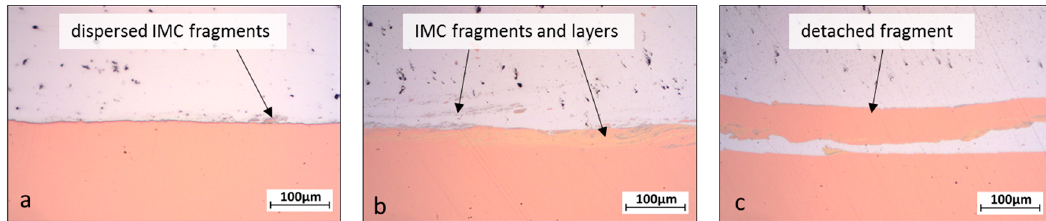
Figure 3. Influence of the pin length on the interface structure: ( a ) 1.8 mm; ( b ) 2.0 mm; ( c ) 2.2 mm; ( d ) 2.4 mm and ( e ) 2.6 mm. AS: Advancing Side, RS: Retreating Side.